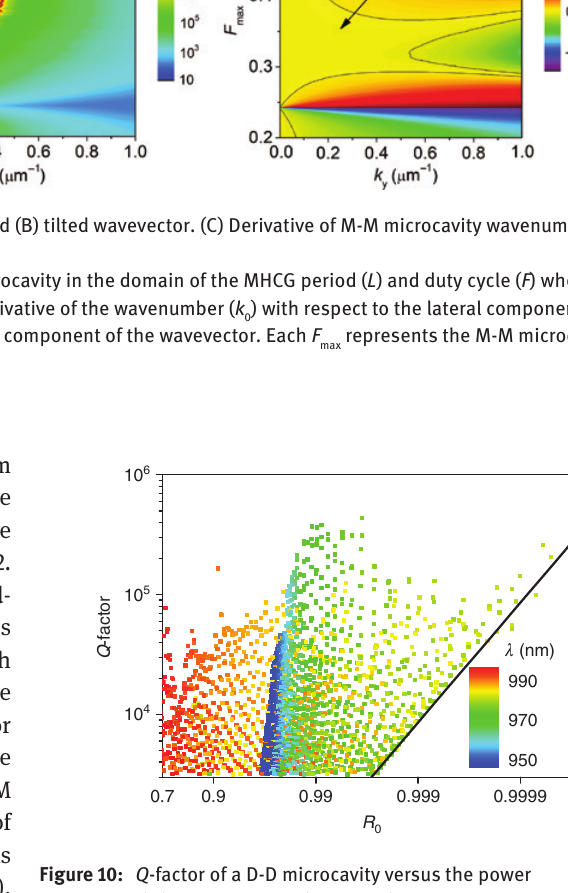
) of the MHCGs (points) 0